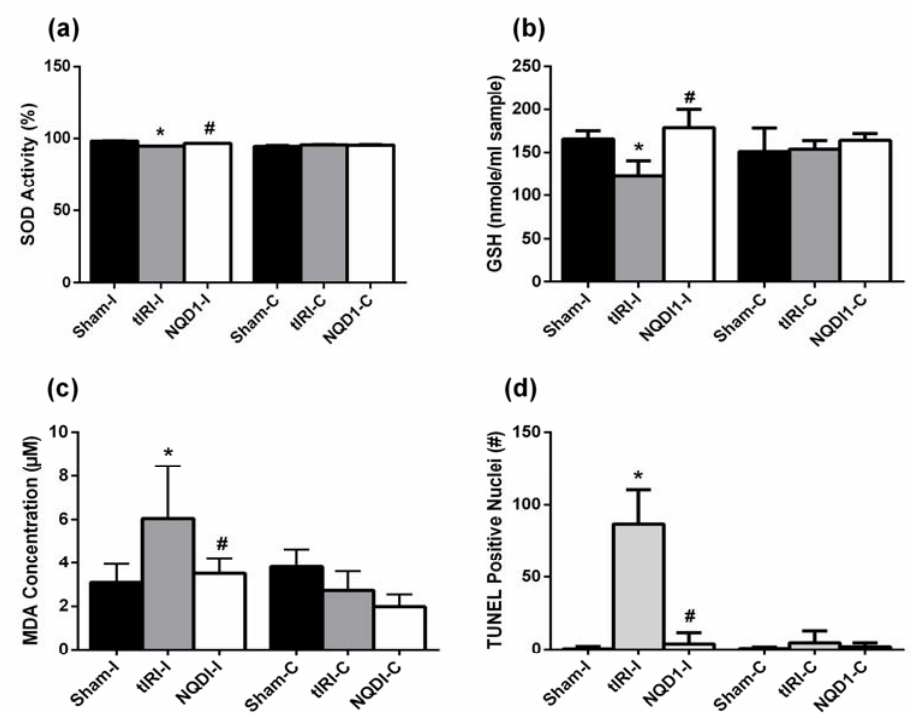
Figure 2. NQDI-1 inhibits testicular oxidative stress. Colorimetric assays were used to analyze ( a ) SOD activity; ( b ) GSH levels and ( c ) MDA concentration, while Terminal deoxynucleotidyl transferase